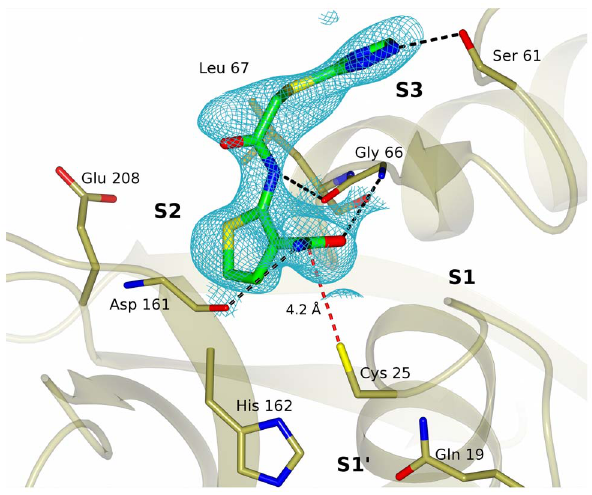
Figure 7. Crystal structure of Neq176 co-crystallized with cruzain showing the mode of binding (MOB) of the inhibitor at the catalytic site of chain B with the unbiased mFo-DFc electron density map shown in cyan. Figure prepared using CCP4mg software [43].